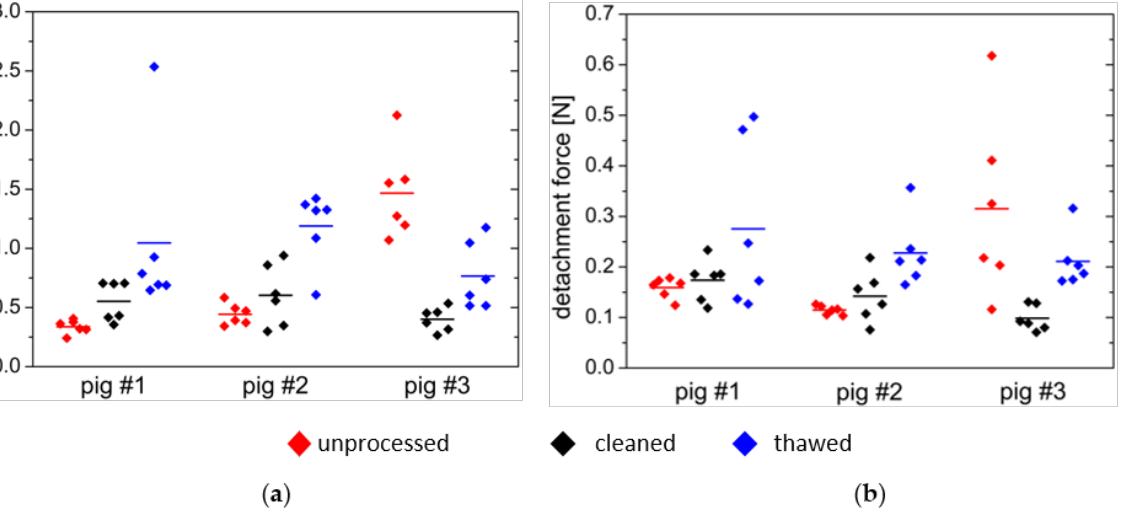
Figure 11. ( a ) Work of adhesion in mN × m and ( b ) maximum detachment force in N required to detach PVA films from differently prepared tissue samples. Shown are the individual data and median, n = 6.